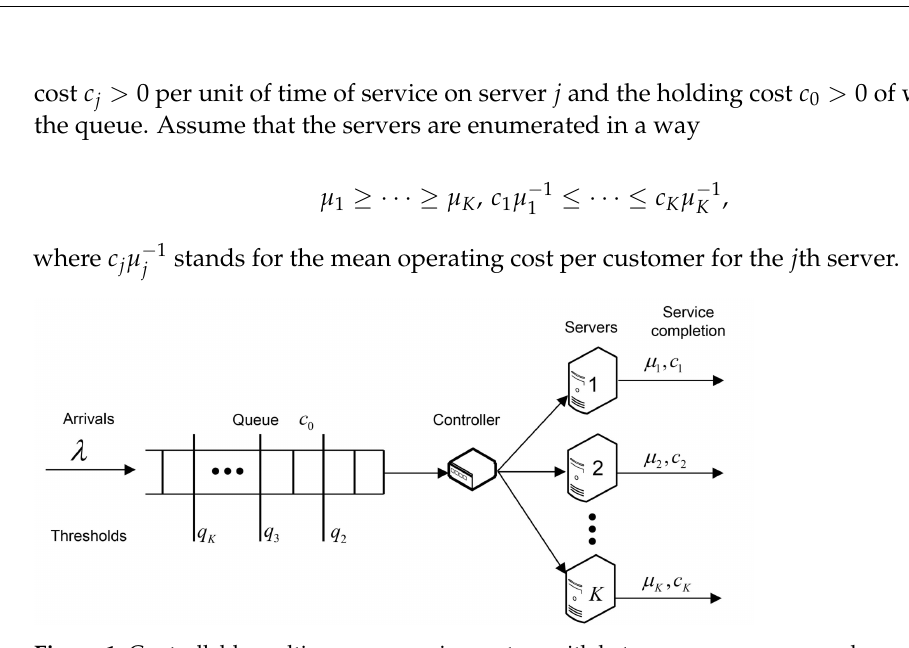
Figure 1. Controllable multi-server queueing system with heterogeneous servers and operating